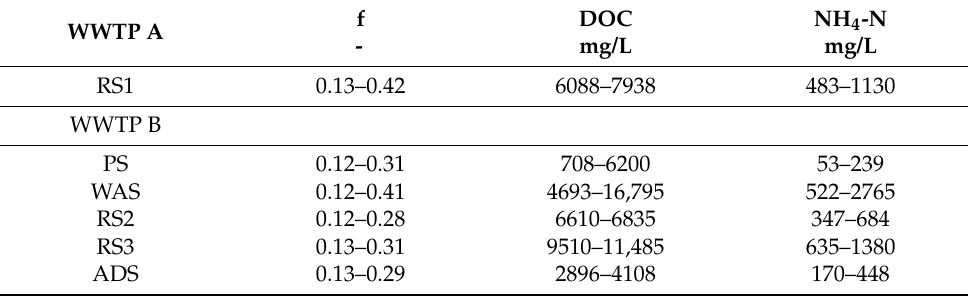
Table 5. Resulting DOC and NH 4 -N in process water of the tested sewage sludges after